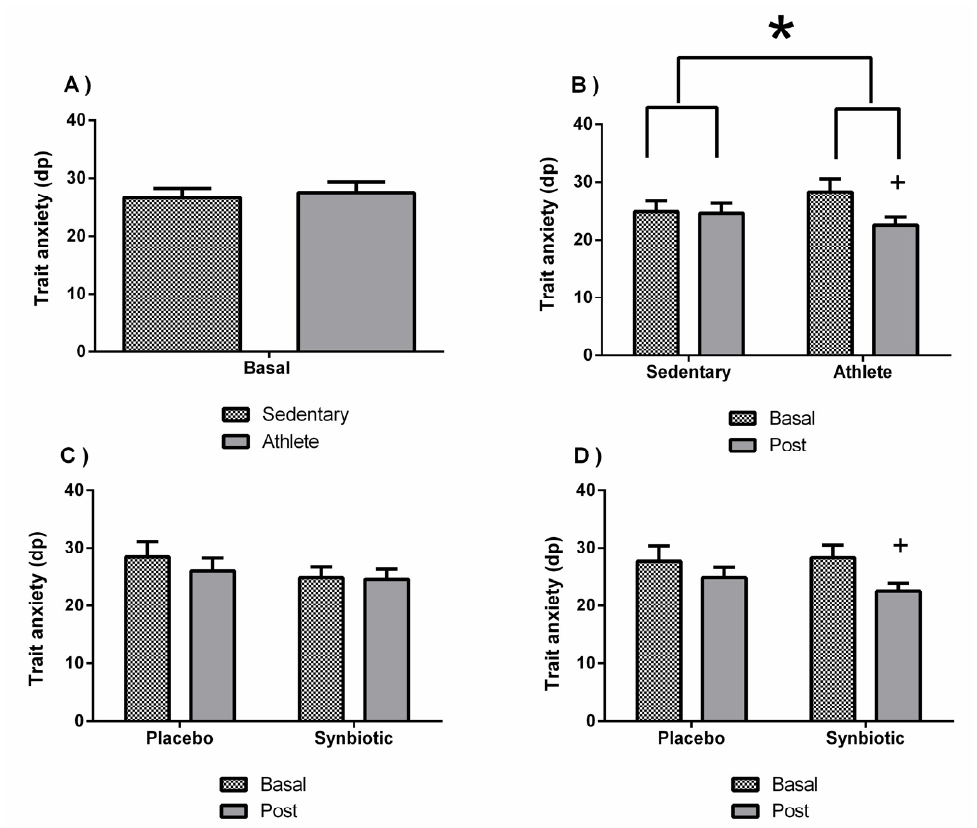
Figure 3. Effect of training and consumption of a synbiotic in this condition on perceived anxiety levels. ( A ) Perceived anxiety levels in sedentary men ( n = 14) and athletes ( n = 13); ( B ) Influence of training on the effects of the synbiotic on perceived anxiety levels ( n = 7 and n = 6 in sedentary and athlete groups, respectively); ( C ) Effect of the consumption on trait anxiety levels in sedentary individuals with respect to placebo ( n = 7) or with synbiotic ( n = 7); ( D ) Effect of the consumption of the synbiotic on perceived anxiety levels in athlete individuals with placebo ( n = 6) or with synbiotic ( n = 7). The determinations are expressed by the mean ± SD of each of the samples. * p < 0.05 sedentary group versus athlete group; + p < 0.05 with respect to the baseline.